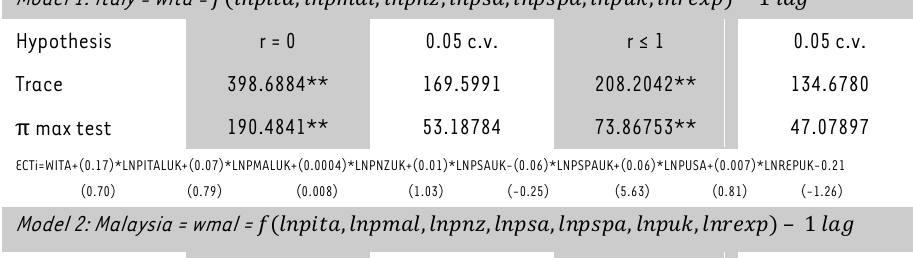
Johansen co-integration test results for the UK Model 1: Italy = wita